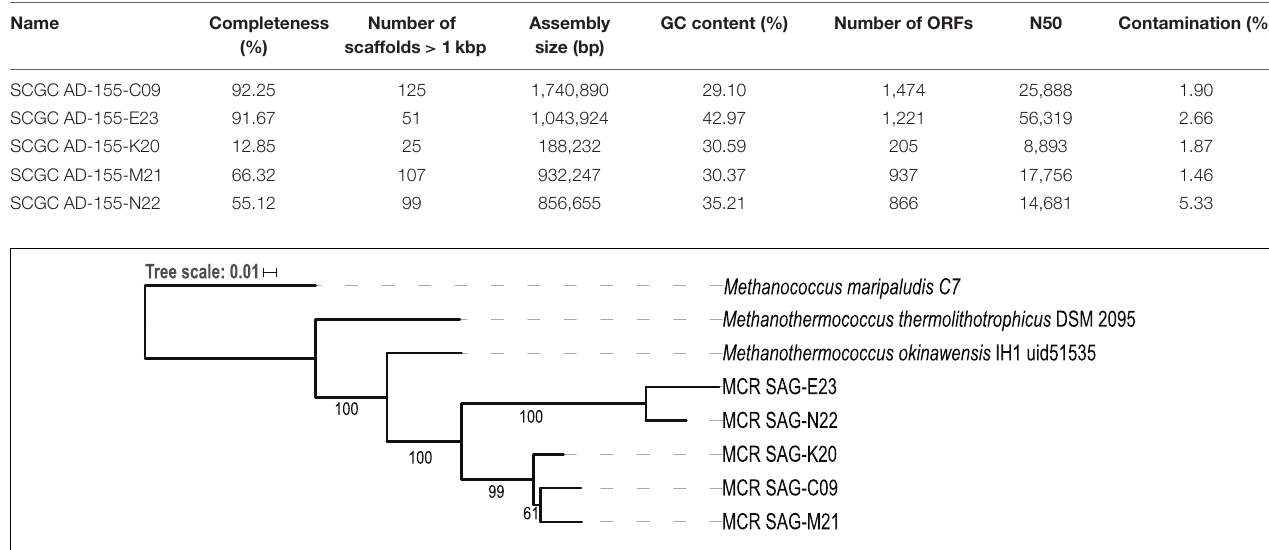
FIGURE 1 | Phylogenetic tree of five Methanothermococcus SAGs from the Mid-Cayman Rise (MCR). Single-copy universal marker genes were identified and aligned with PhyloSift. The tree was built with RAxML using 100 bootstraps. Bootstrap values higher than 50 are indicated on the tree. Each of the SAGs sequenced for this study was labeled as “MCR SAG” in the tree for clarity. The scale bar reflects branch lengths in terms of substitutions per site.